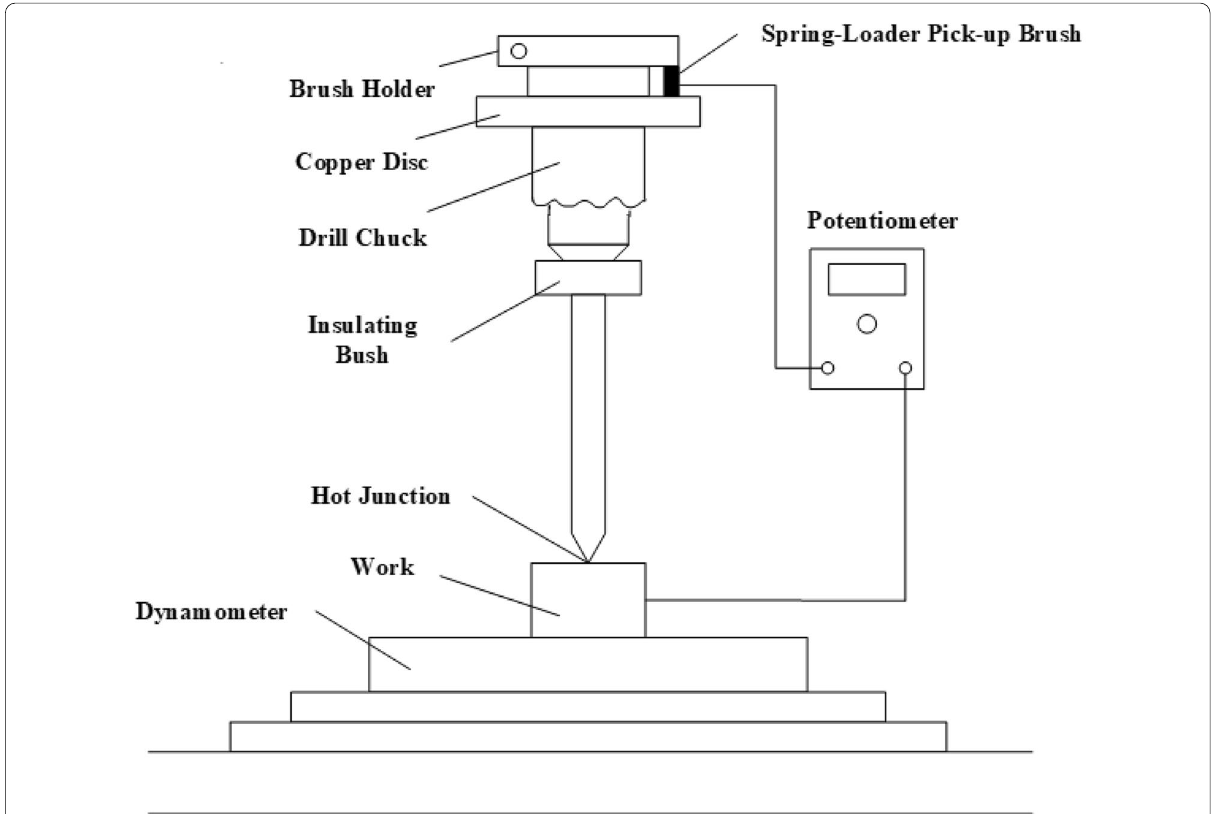
Figure 5 Tool-work Thermocouple